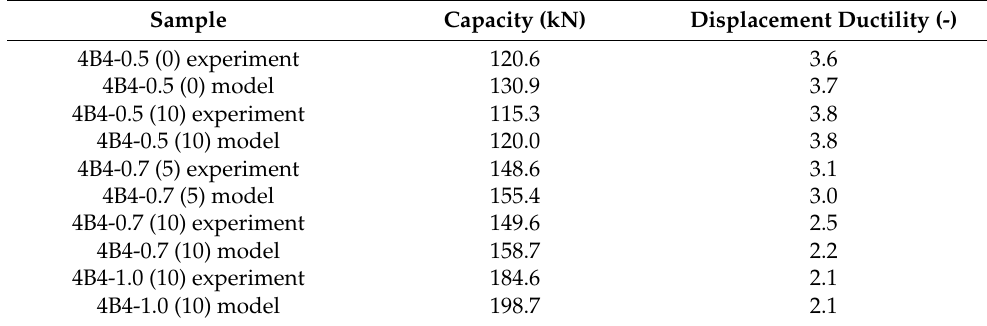
Table 2. Comparison of results from [26] with theoretical model